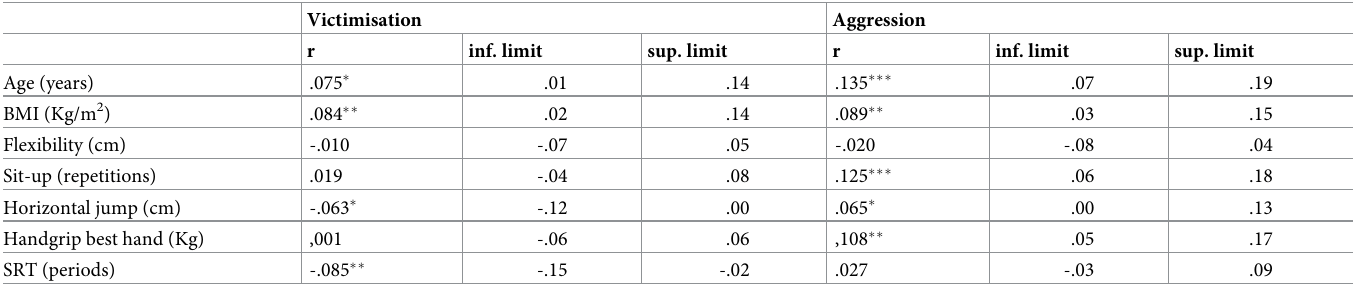
Table 4. Linear correlations with victimisation and aggression of anthropometric and physical fitness variables. Victimisation inf.